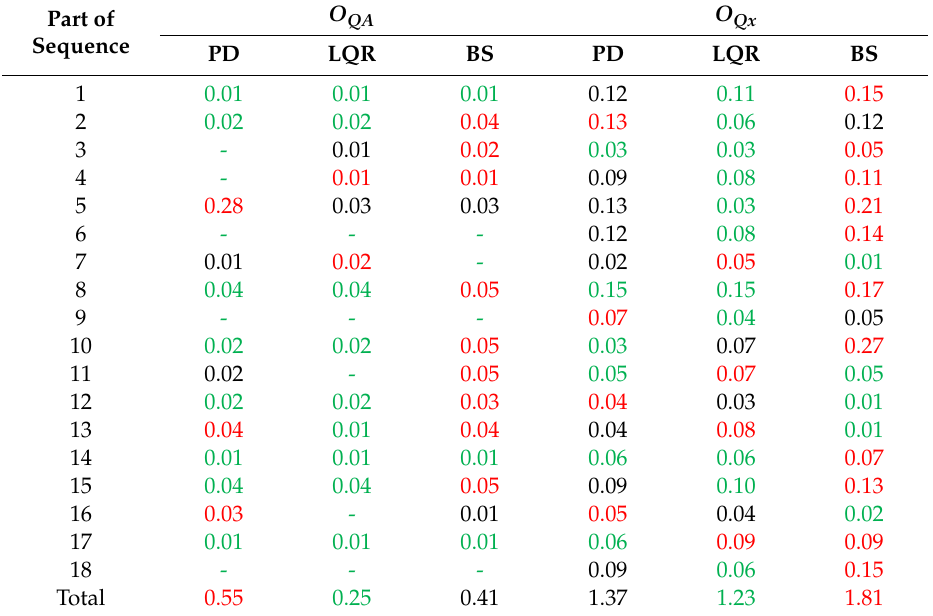
Table A6. Quality indicators of controllers’ performance: Maximal absolute variation of scalar part of quaternion O QA and the vector part of the quaternion related to x axis O Qx (PD—PD controller, LQR—LQR controller, BS—backstepping